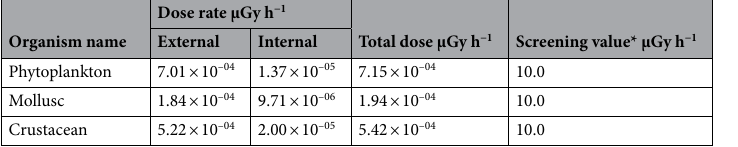
Table 2. External, internal, and total dose rate per organism in comparison with ERICA dose rate screening value. * ERICA dose rate screening value.